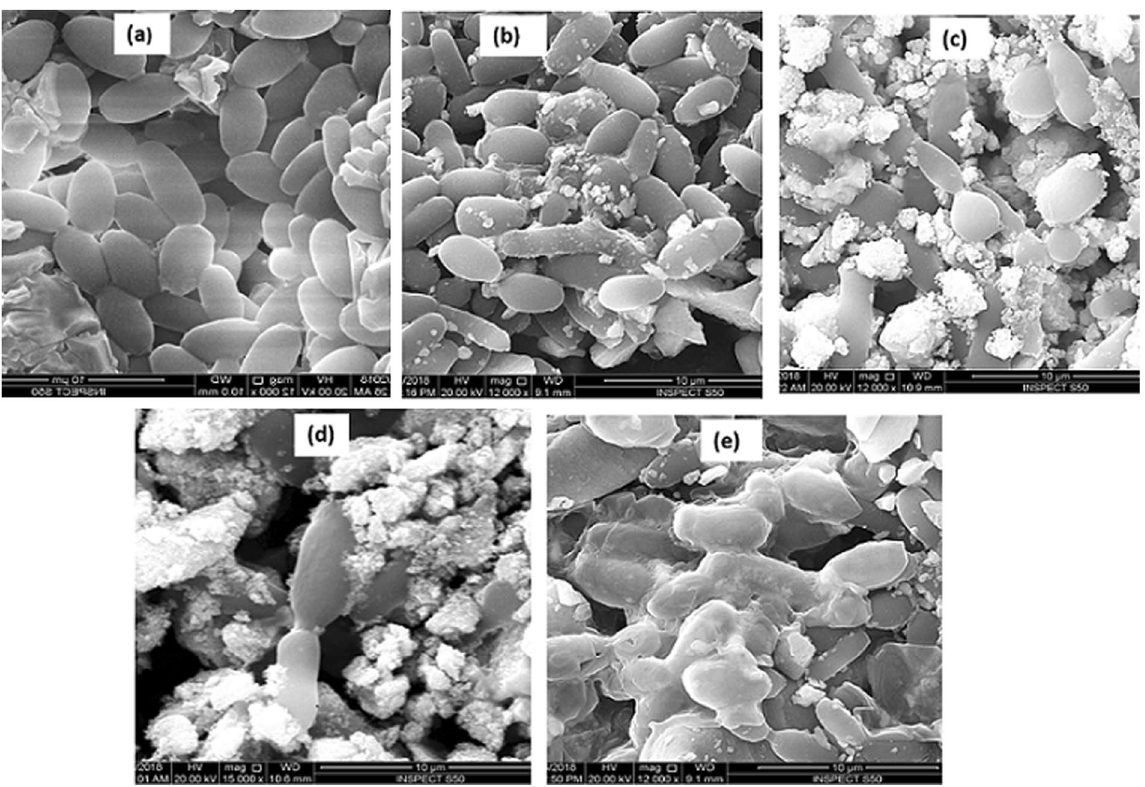
Figure 5. SEM micrographs of C. albicans ( a ) untreated (control): treated with ( b ) pure In 2 O 3 NPs, ( c ) 5%, ( d ) 10%, and ( e ) 15% Sn doped indium oxide NPs.